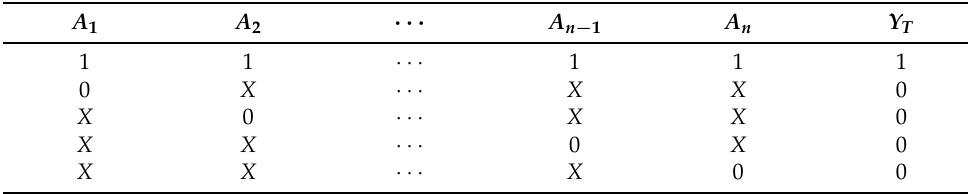
Table 6. Encoding for activation with all sets on